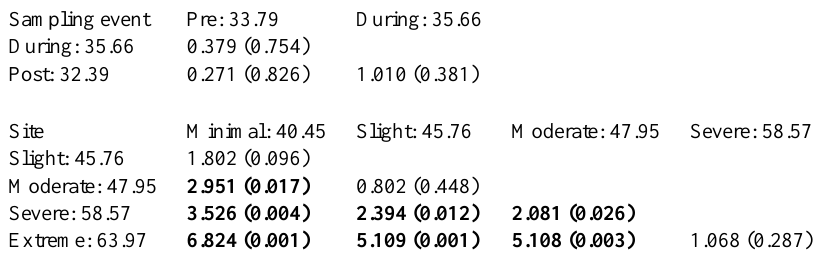
Table 5. Results of PERMDISP tests for macroinvertebrate community dispersion comparisons grouped by event (pre-, during-, post- dewatering) and site (strength of dewatering impact). The dispersion value for each group is listed adjacent to the group name. PERMDISP t- values for the comparisons are shown, with corresponding p-values in parentheses. Statistically-significant community dispersion differences are in bold.